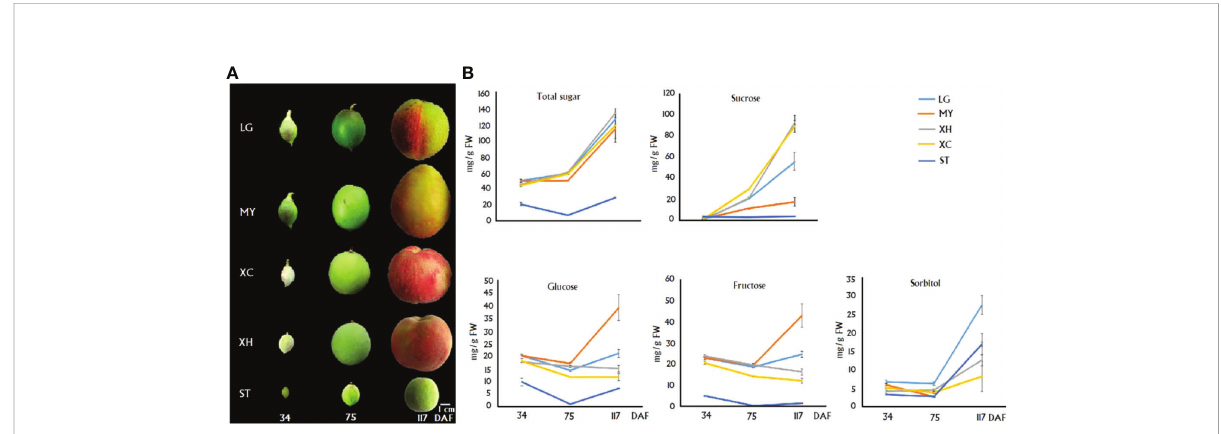
FIGURE 1 Graphical presentation of fruits at three differenet development stages. (A) and the correspoding sugar contents (B) in four cultivars and a wild relative ST. Total sugar represents the sum of glucose, fructose, sucrose and sorbitol. Error bars indicate the standard error (SE) of three biological